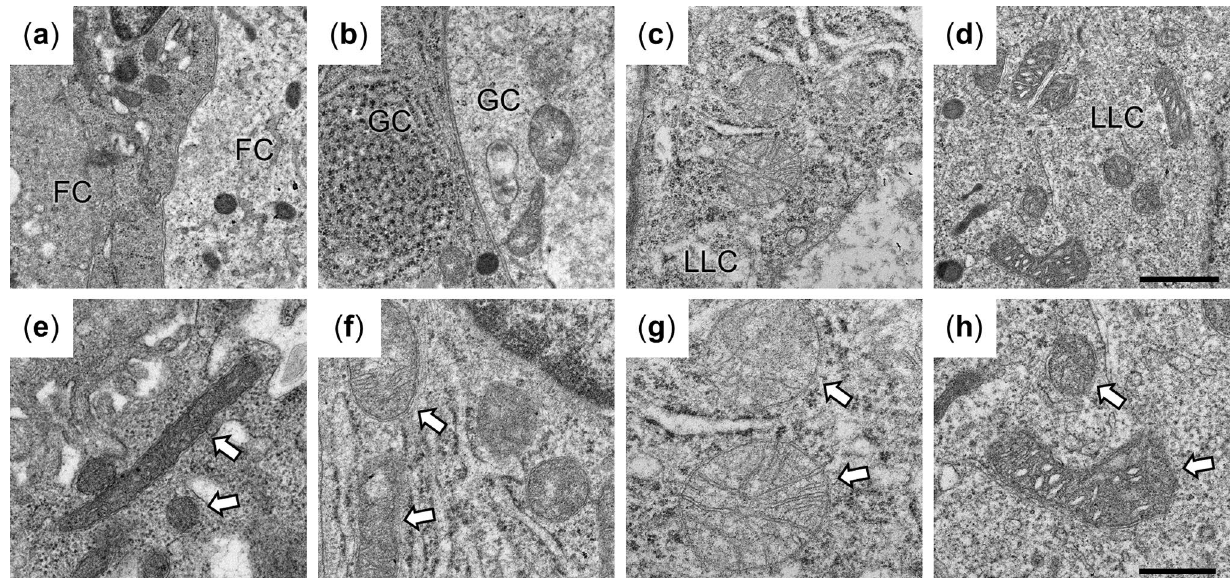
Figure 3. The TEM images show distributions of mitochondria ( a – d ) and cristae structures ( e – h ) in goat FC ( a , e ), GC ( b , f ), LLCs in CH ( c , g ) and LLCs in CL ( d , h ). The white arrows indicate mitochondria shown at high magnification. Bar: 1 μm ( a – d ) and 0.5 μm ( e – h FCs in PFs (Fig. 2a,e), the basal columnar GCs in MF (Fig. 2b,f), the LLCs with large cell size (~ 20 μm) in CH (Fig. 2c,g) and CL (Fig. 2d,h). 2D mitochondrial structures in goat LLC lineage. To assess mitochondrial structure, 2D cellular images of goat LLC lineage were collected at higher magnifications (Fig. 3). In the cytoplasm of PFs, small round- and rod-shaped mitochondria could be found (Fig. 3a,e). Although the double membrane was discern- able in our specimens, no highly organized cristae were observed (Fig. 3e). In GCs, the mitochondrial shapes were similar to those in PFs (Fig. 3b,f). However, the connectivity of organelles could not be properly evaluated from the 2D images. In mitochondria, both pale- or dark-staining matrix were found. The cristae may form lamellar structures, which are observed as parallel straight lines in the organelle (Fig. 3f). In the LLCs from